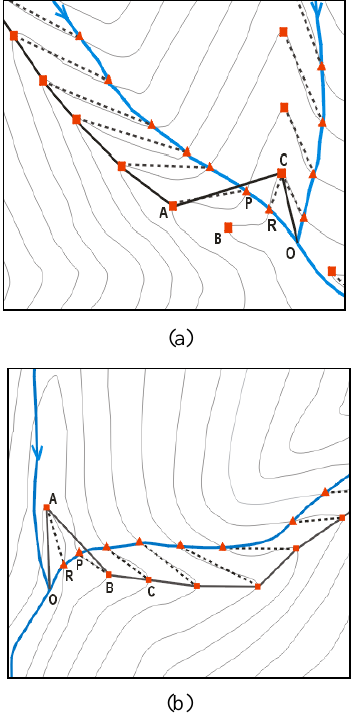
Figure 5. The wrong matching